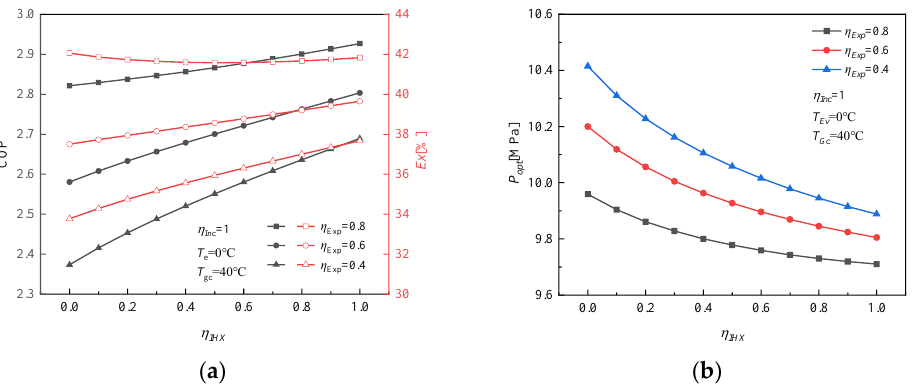
Figure 6. Effect of η IHX on the system performance at different η Exp : ( a ) Variation of COP and exergy with η IHX ; ( b ) Variation of optimal discharge pressure.